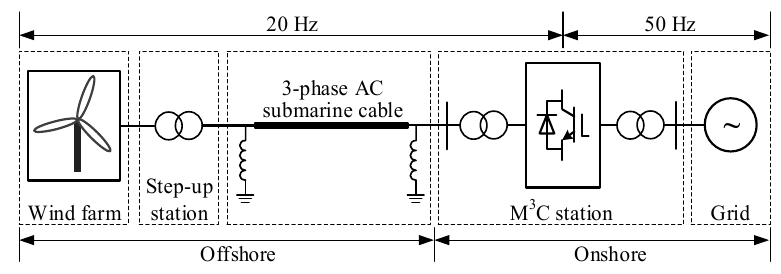
* vd i Figure 7. Active power control loop of outer loop controller on output side of M3C. 5.2.2. Reactive Power Control Loop In accordance with (53), i vq* can be directly calculated when Q os* is given; yet to elim- inate the steady-state error, the negative feedback of the reactive power by the PI control- ler is required. Therefore, the reactive power control loop with given Q os* is illustrated in Figure 8a. Figure 8b represents the reactive power control loop with prescribed U om* . In addition, the output i vq* of the reactive power control loop should be limited to avoid the overload of the M3C. Analogously, the upper limit i vqmax is given by: 2 ( b ) Figure 8. Reactive power control loop of outer loop controller on output side of M3C when ( a ) Q os* is given; ( b ) U om* is given.